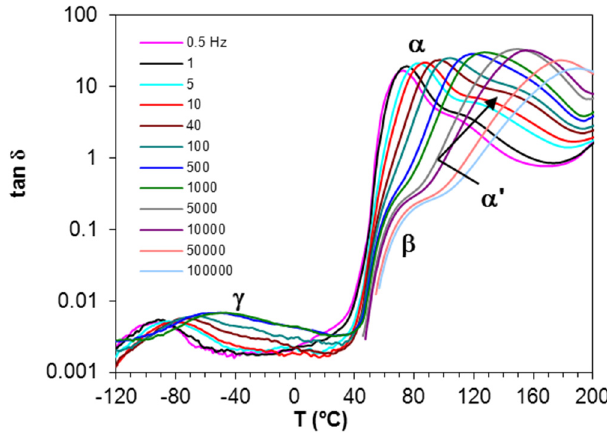
Figure 4. Dielectric relaxation spectroscopy curves (DRS) for PEI2000-PLA5 at 0.5 °C/min over the frequency range from 0.5 Hz to 100 kHz, as defined in the inset.